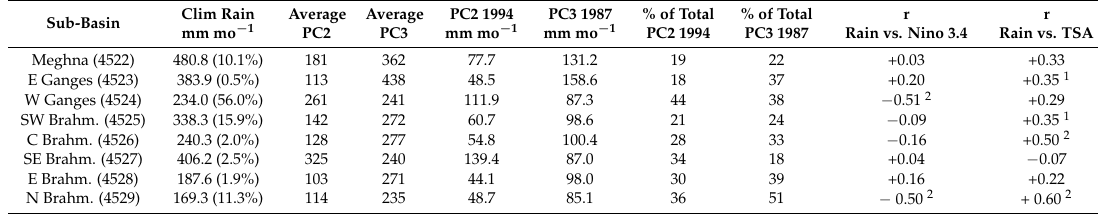
Figure 4. Boundaries of the Pfafstetter level-04 hydrologic units for the GBM. Colors denote Brahmaputra, Ganges, or Meghna basins. Number is the Pfafstetter identification code. Table 1. Statistics for the eight Pfafstetter level-04 hydrologic units (see Figure 3). 1983–2015 climatological rainfall and percentage of total water delivery, PC2 and PC3 averages, average PC2 and PC3 rainfall for 1994 and 1987 respectively, percent of the total rainfall contributed by PC2 and PC3 for 1994 and 1987 respectively and correlation coefficient between June-July-August-September (JJAS) average precipitation and JJAS Nino 3.4 and TSA from 1983 to 2015.